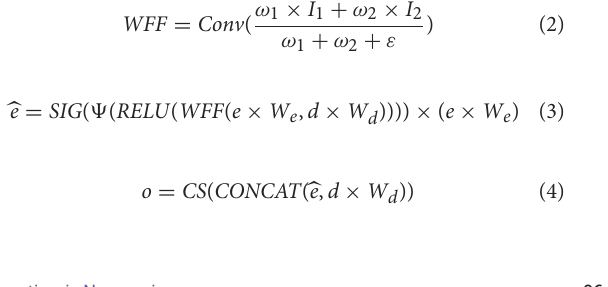
obtaining feature o for target